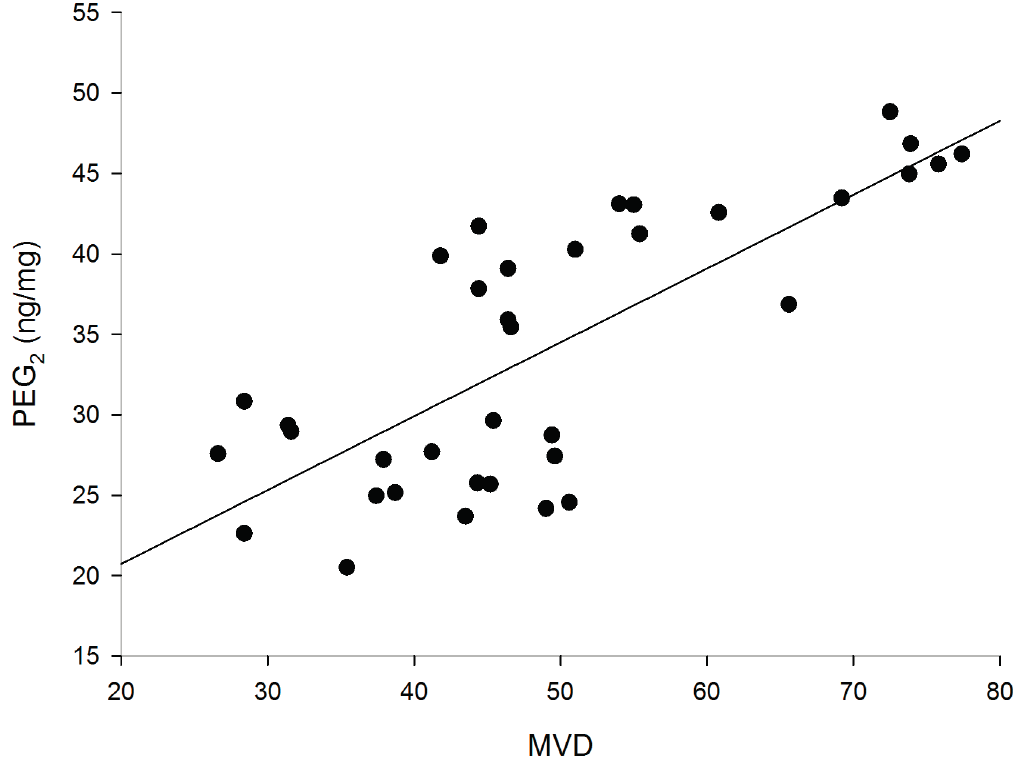
Figure 5. Correlation between the expressions of PGE 2 and MVD ( r = 0.764, p < 0.01).